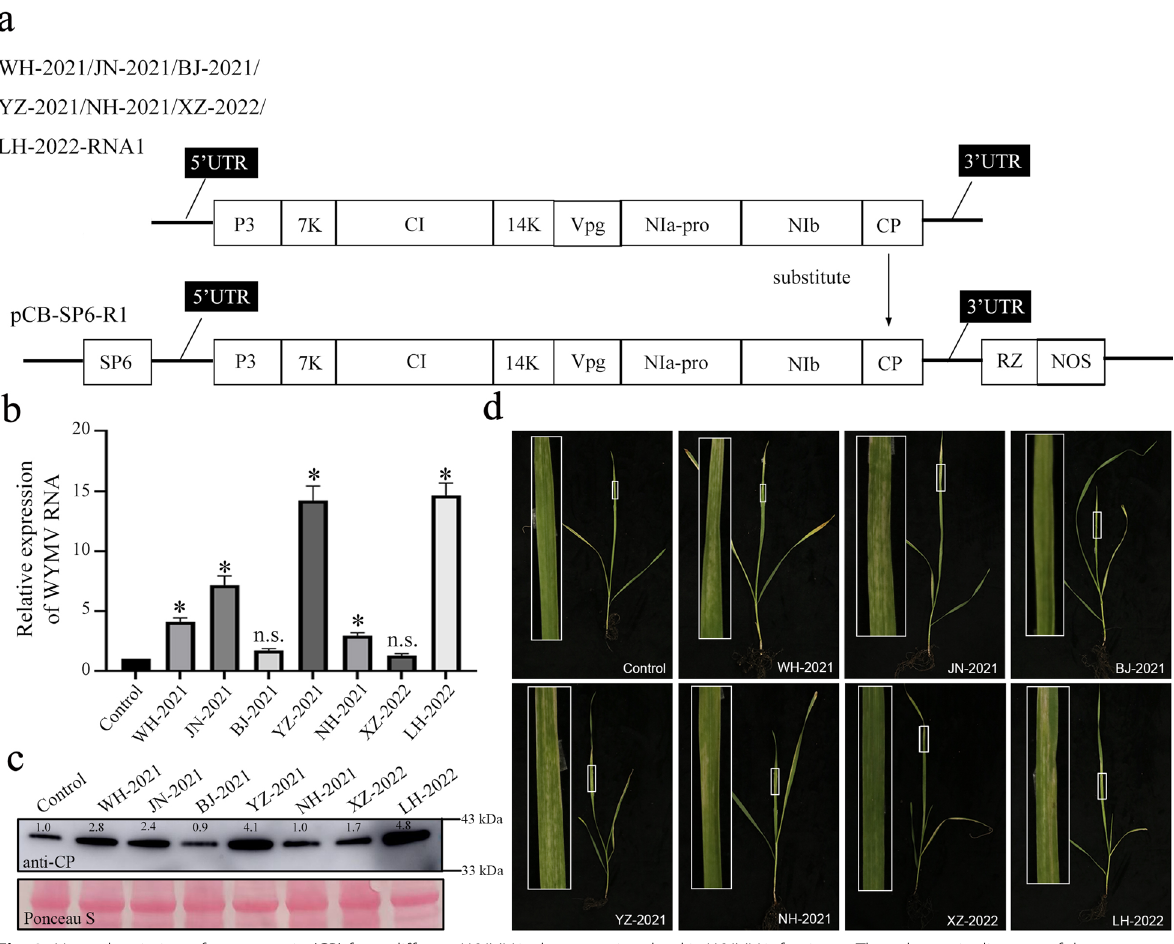
Fig. 3 Natural variation of coat protein (CP) from different WYMV isolates was involved in WYMV infection. a The schematic diagram of the infectious clones containing CP from different WYMV isolates (Wuhu-2021, Junan-2021, Baoji-2021, Yangzhou-2021, Ninghai-2021, Xuzhou-2022, and Luohe-2022). The CP on the previous WYMV infectious clone was replaced by the nucleotides of the CP sequence of different WYMV isolates obtained in this study. pCB-SP6-R1 represented of the WYMV infectious clone. b Relative expression of viral RNA in the systemic leaves of wheat plants inoculated with the infectious clones containing CP from different WYMV isolates at 28 days post-infiltration (dpi). Data shown are the means of three biological replicates the SE. The values were normalized to those for the reference gene (Cell Division Control protein, TaCDC ) ± and are presented as fold changes in expression relative to that in control plants. Asterisks indicate significant differences in expression between wheat leaves inoculated with control and the infectious clones containing CP from different WYMV isolates when analyzed using a Student’s t -test ( P < 0.05). Control, wheat leaves inoculated with WYMV infectious clones which were constructed in previous study. c The systemic leaves of the wheat plant inoculated with the infectious clones containing CP from different WYMV isolates were harvested for testing the accumulation of viral protein by Western blot assay using CP specific antibody at 28 dpi. d The phenotype of wheat plants inoculated with the infectious clones containing CP of different WYMV isolates at 40